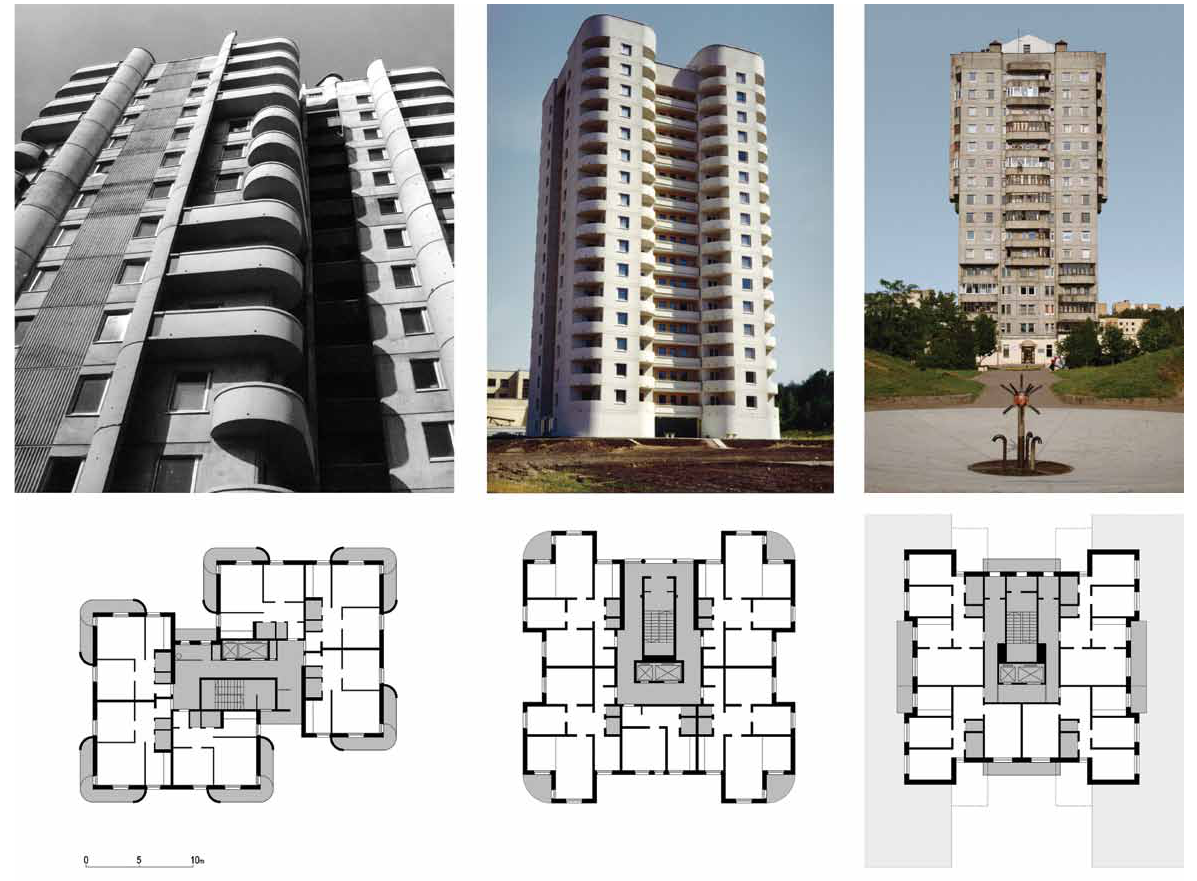
10 pav. Monolitinis gyvenamasis namas Šeškinėje (archit. Bronius Krūminis, Danas ruseckas; statytas nuo 1983 m.) Fig. 10. Monolithic tower block in Šeškinė (archit. Bronius Krūminis, Danas ruseckas, constr. st. in 1983 m.)